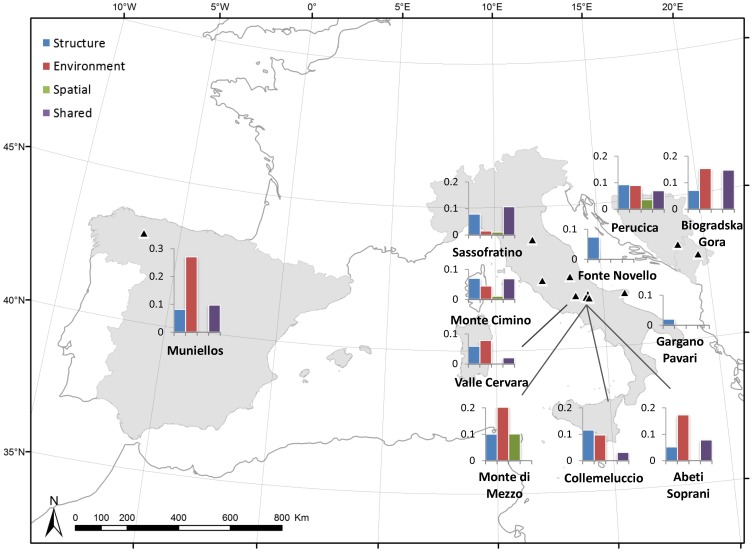
Fractions of Variation explained per stand.Fractions of variance in ground layer species turnover explained by multiple regression on distance matrices models (MRMs) in 11 old-growth beech forest stands. Bar charts report the relative explanatory power of forest structure, abiotic environment and spatial distance. Each pie-chart is placed next to the triangle that indicates the geographical location of the corresponding site. Negative shared fractions are not shown.